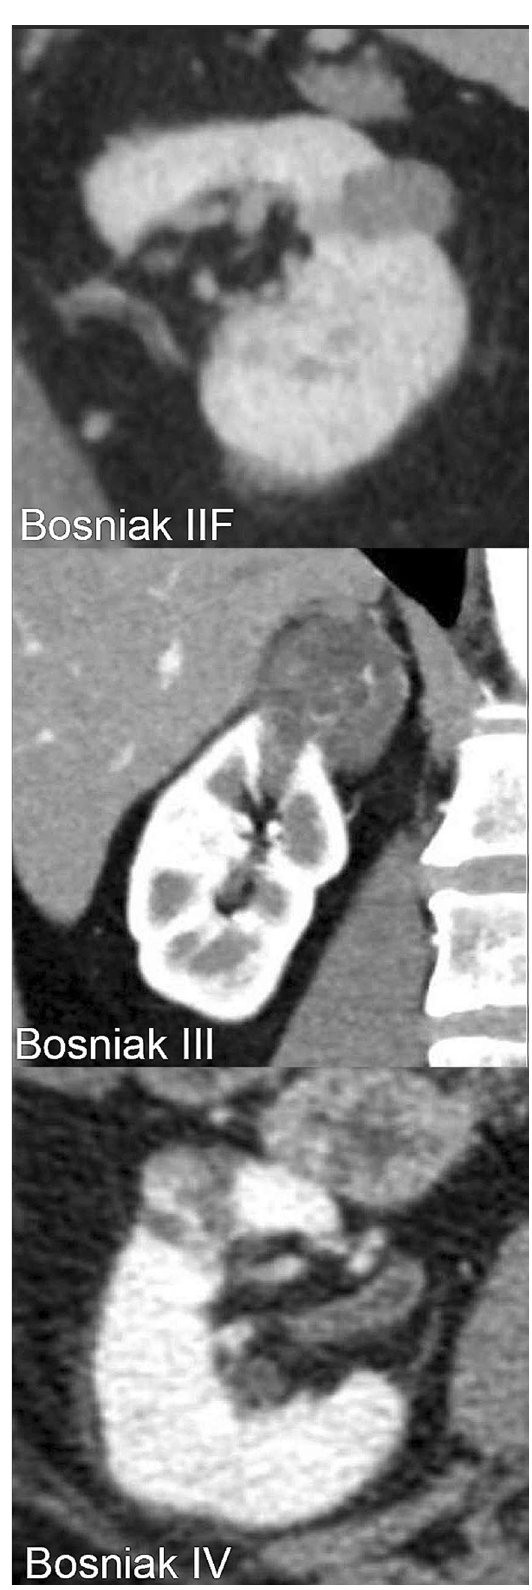
Figure 1. Cystic renal masses of Bosniak classification IIF, III and